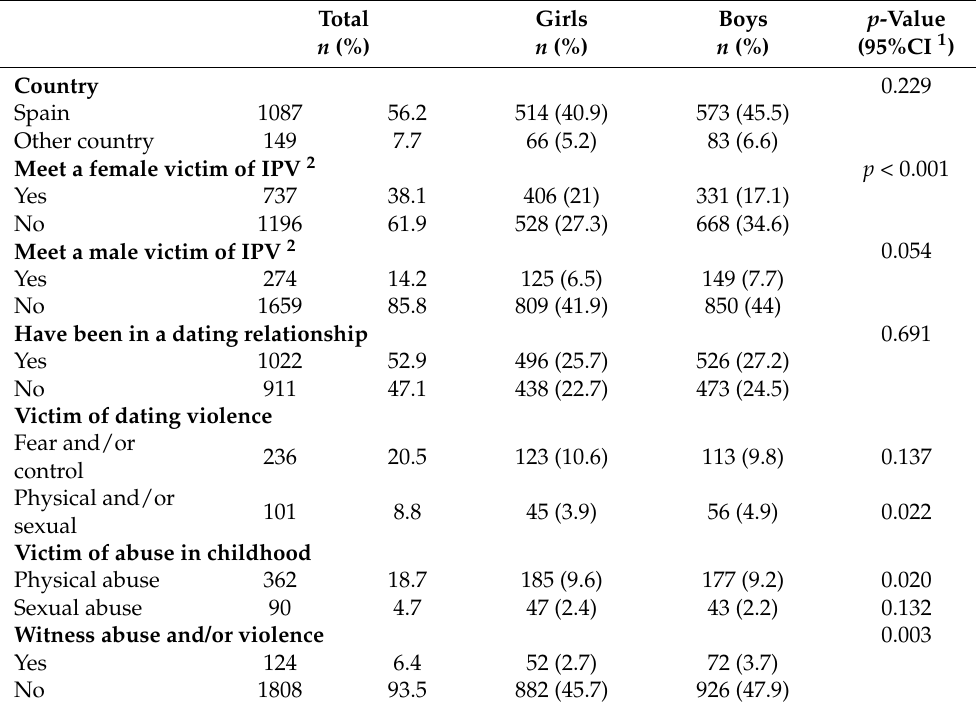
Table 1. Sociodemographic characteristics of the sample and violence variables by sex.